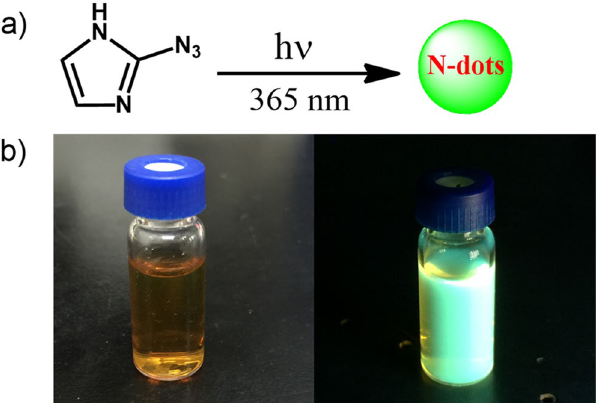
Figure 1. ( a ) Synthesis of N-dots. ( b ) Digital image (left) of 1.0 mg/mL N-dots in water and its photoluminescence image (right) under hand-held UV lamp (365 nm).